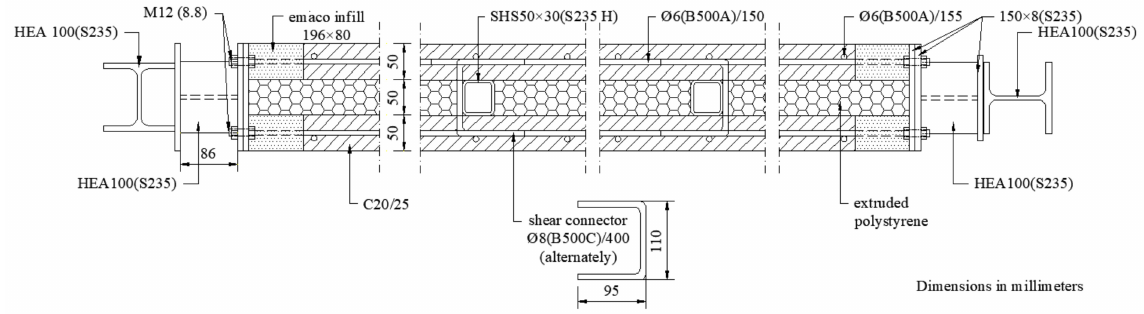
Figure 20. Top schematic view of the PCSP-ISF